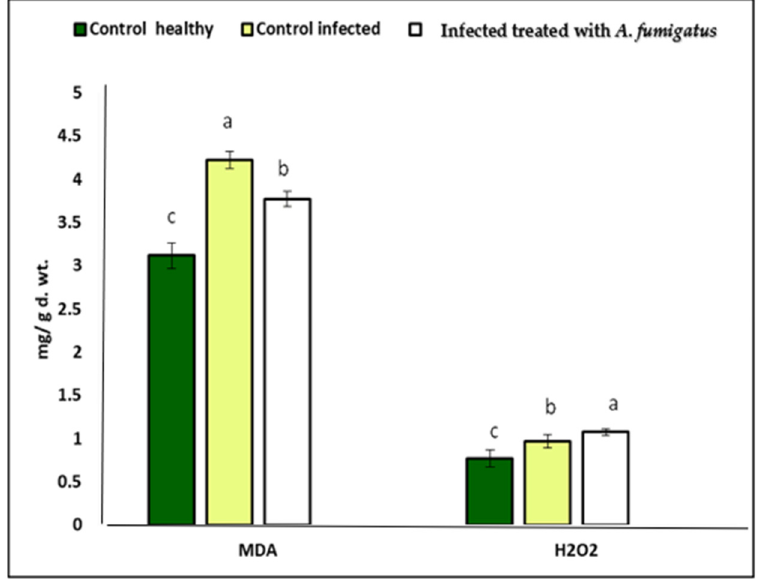
Figure 8. Effect of A. flavus and treatment with of A. fumigatus on (MDA) mg/g. dry weight and (H 2 O 2 ) mg/g. dry weight of Maize seedlings. Data are expressed as means ± standard deviations of triplicate assays. The different alphabetic superscripts in the same column are significantly different ( p < 0.05) means highly significant.